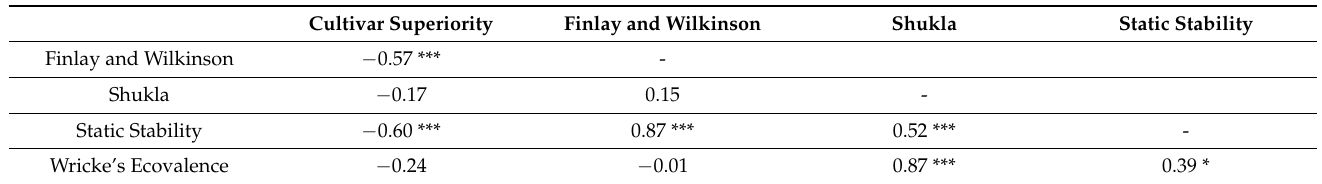
Table 5. Spearman’s coefficients of rank correlation for five stability parameters analyzed for grain yield of lentil accessions tested in different